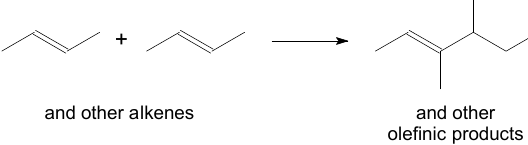
Figure 5. Alkene oligomerisation, illustrated by the dimerisation of trans -2-butene.